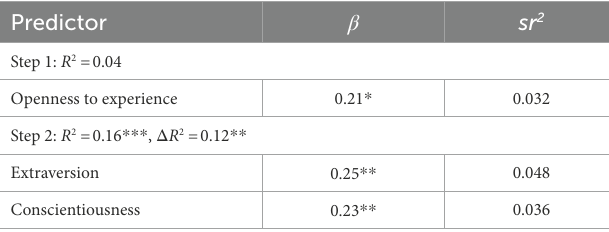
TABLE 3 Hierarchical regression results for effects of personality predictors on work creativity (openness at Step 1; extraversion and conscientiousness at Step